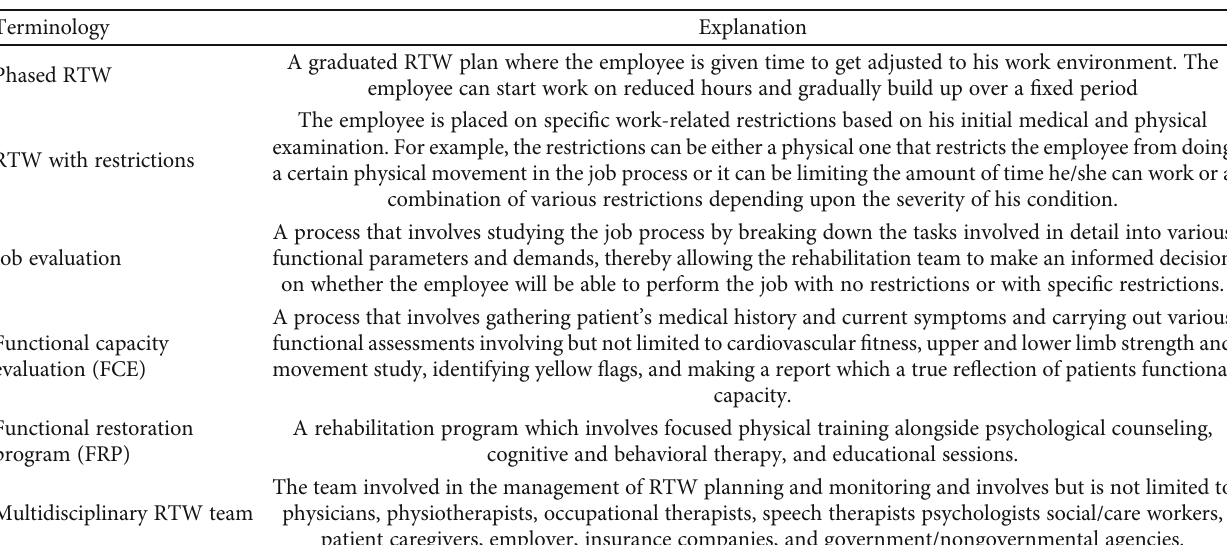
Table 2: Commonly used terminologies for RTW assessment and rehabilitation.